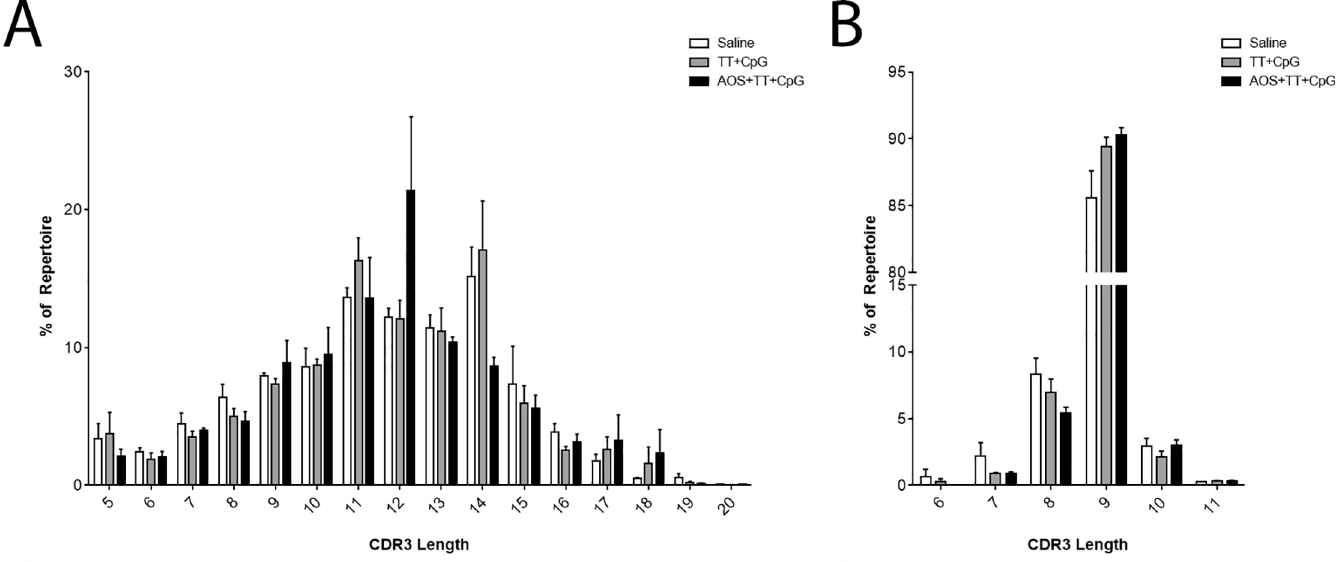
Fig 11. CDR3 AA Length For Heavy chain (A) and Kappa (B) chain in Mice treated with Saline, TT+CpG, or AOS+TT+CpG. No significant differences were detected.